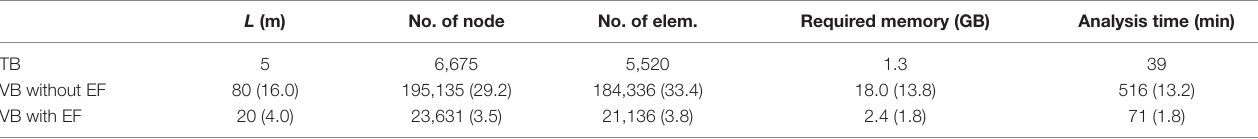
TaBle 6 | comparison of analysis load (cases whose differences of building response are < 10%). no. of